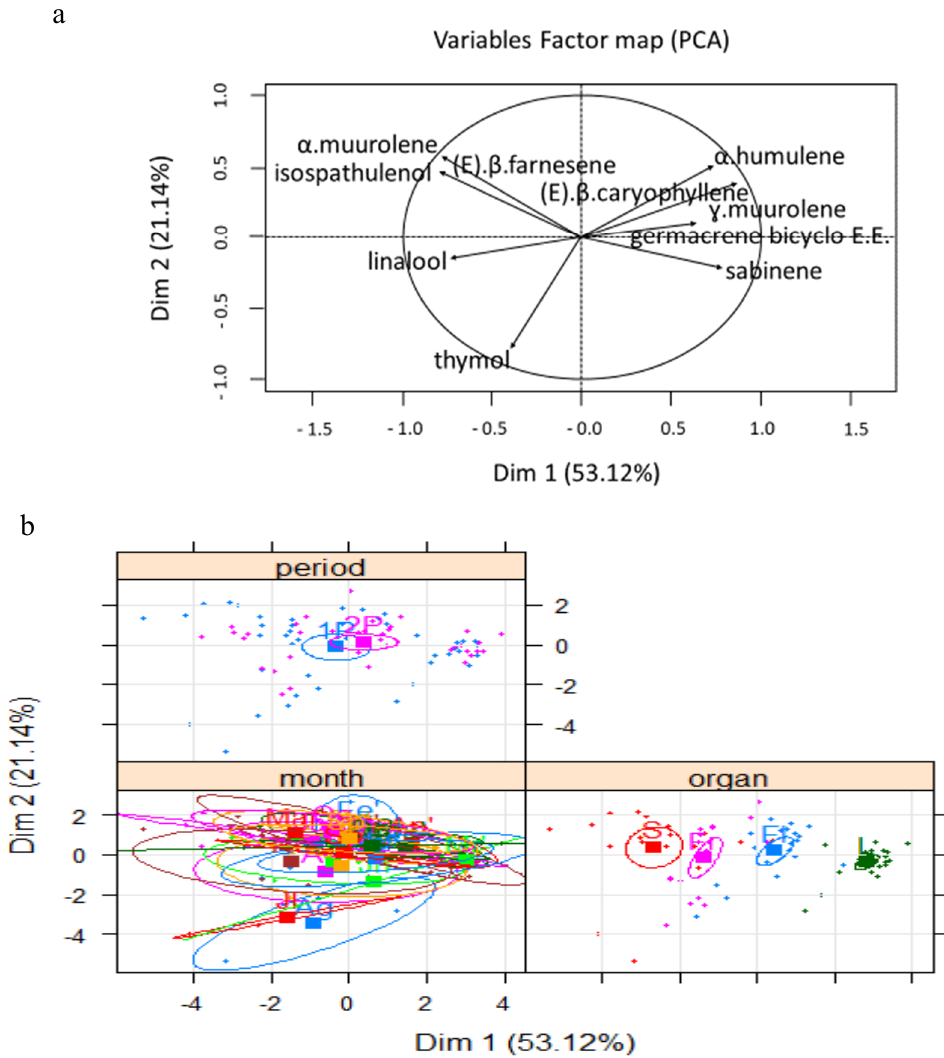
Figure 2. ( a ) Variables factor map of principal component analysis (PCA). ( b ) Sample map of PCA.